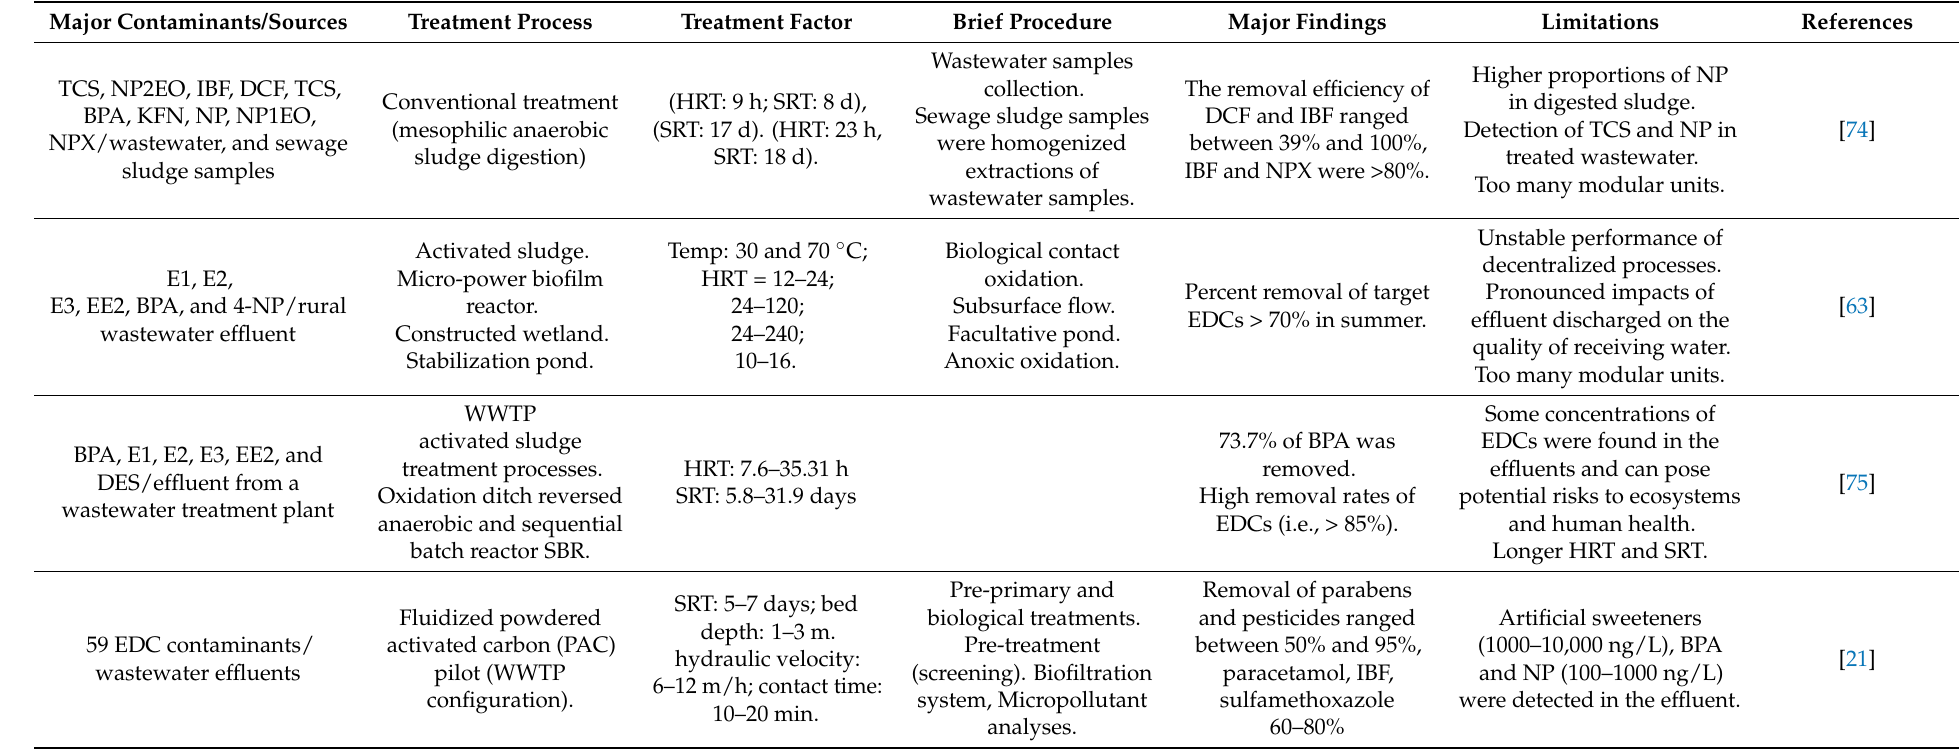
Table 2. Treatment by conventional